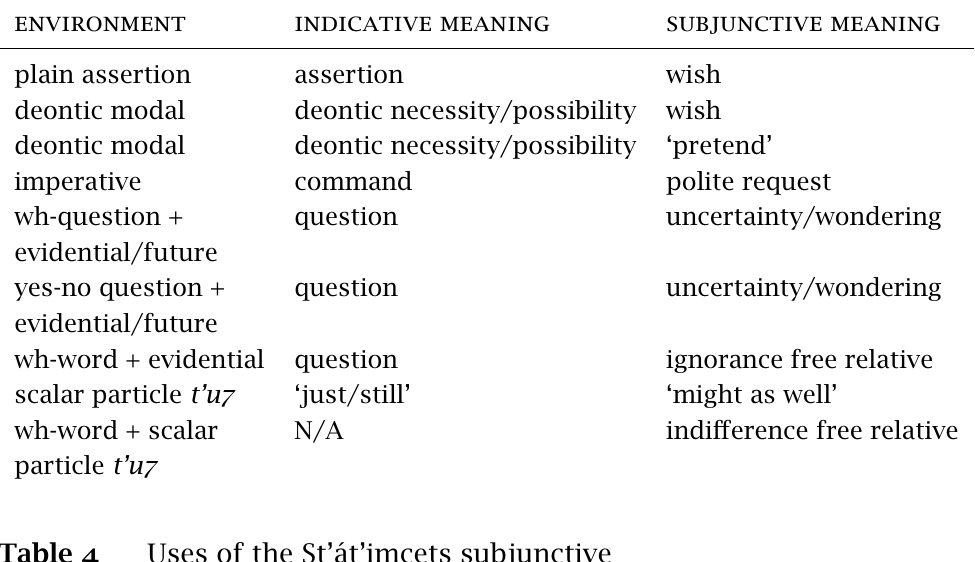
Table 4 Uses of the St’át’imcets